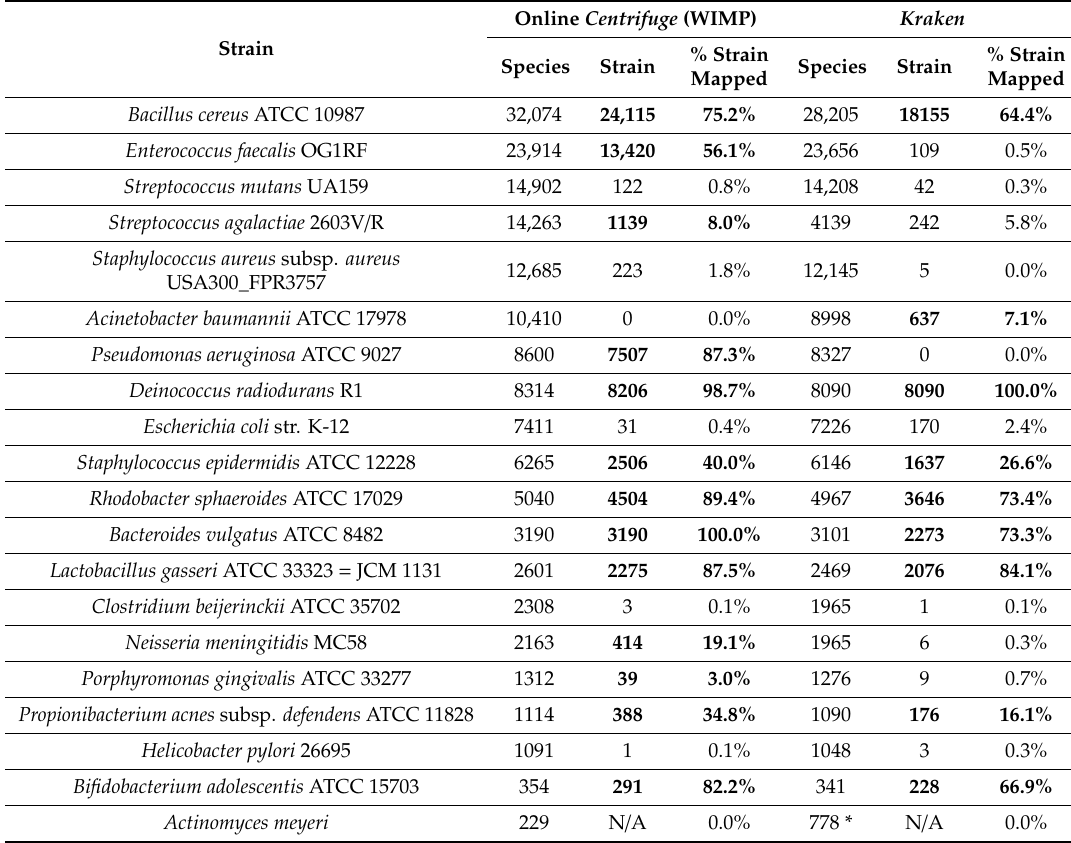
Table 4. Percentage of ATCC MSA-2002 reads mapped to strain by ONT’s cloud-based “What’s In My Pot” (WIMP) and o ffl ine Kraken taxonomic classifier. Strains are listed as they are referred to in NCBI’s RefSeq genome database. Reads and percentages in boldface had the highest number of strain reads mapped per